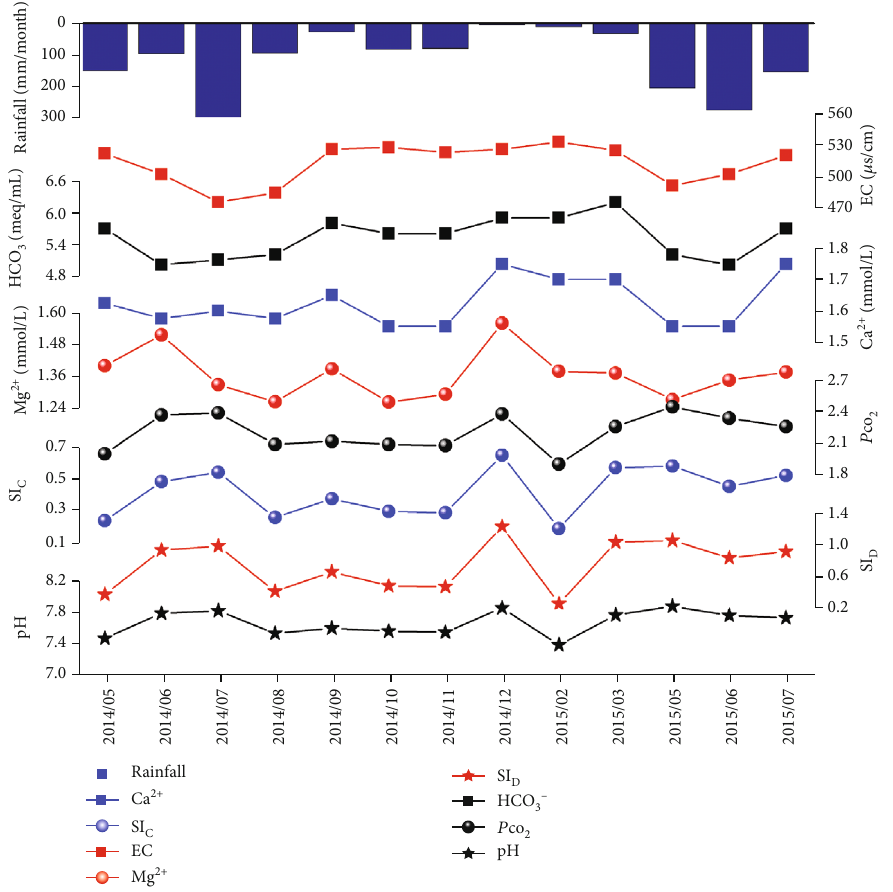
Figure 6: Monthly variation of the hydrochemistry of No. 29 water in YYD spring.